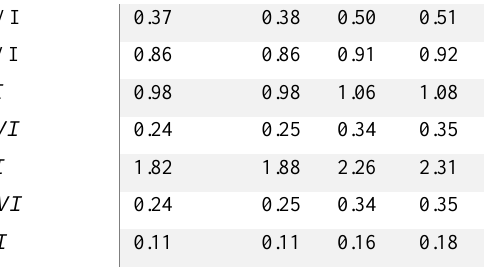
Table 2. Vegetation indices averaged and observed surface reflectance averaged used for all dates in the study